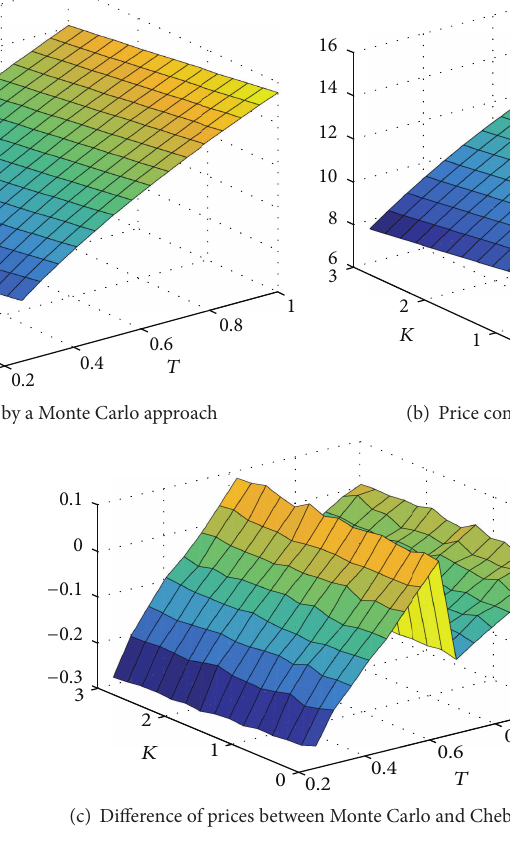
Figure 3: Prices of a spread contract with maturity between one month and one year and strike price between 0 and 3 dollars under the benchmark parametric set. (c) Difference between prices obtained for both methods.